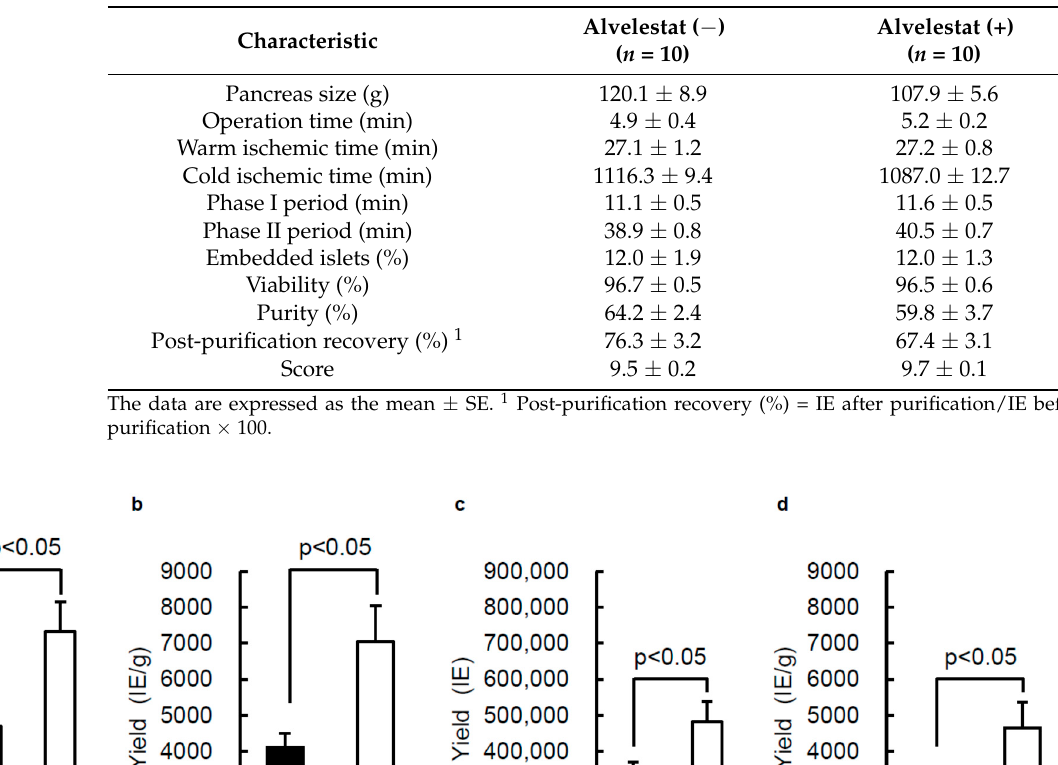
Table 1. Characteristics of the pancreatic tissue and isolated islets in the alvelestat ( − ) group and the alvelestat (+) group.